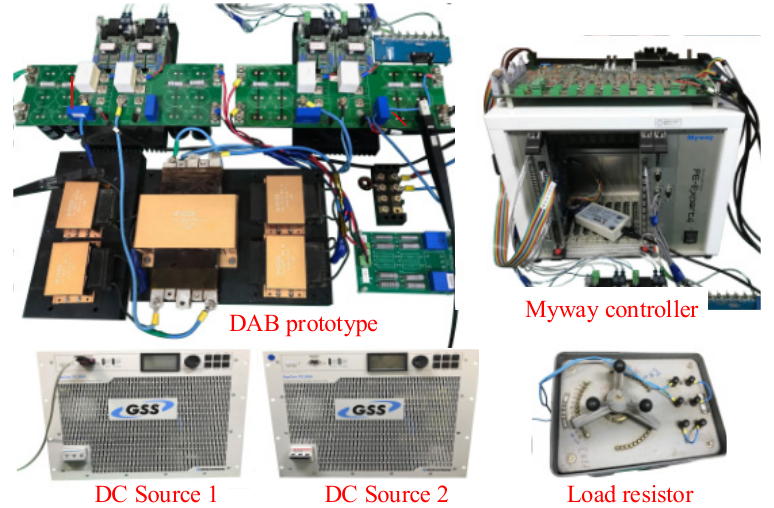
Figure 7. Experimental platform. Table 2. System Parameters.